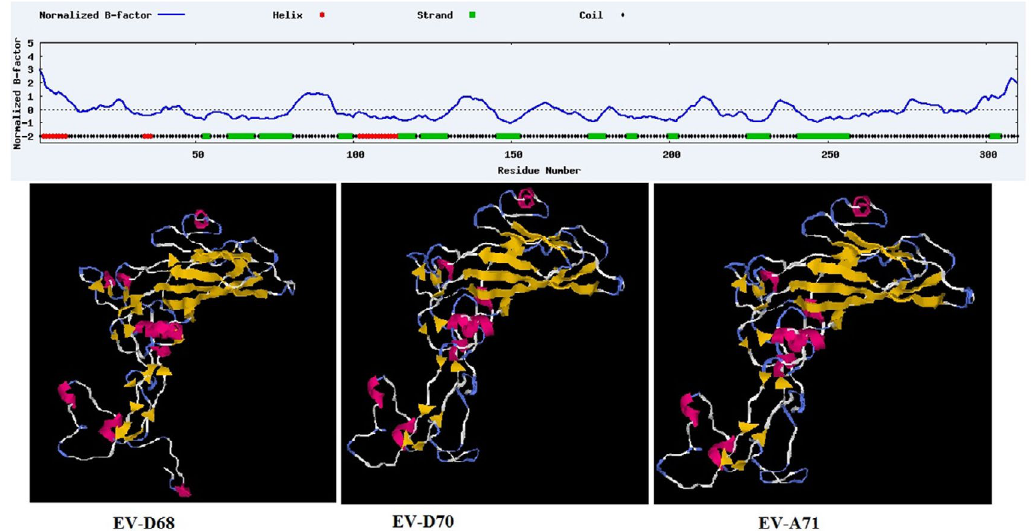
Fig. 1. 3D image of the VP1 structural protein of EV (from I-TISSAR;